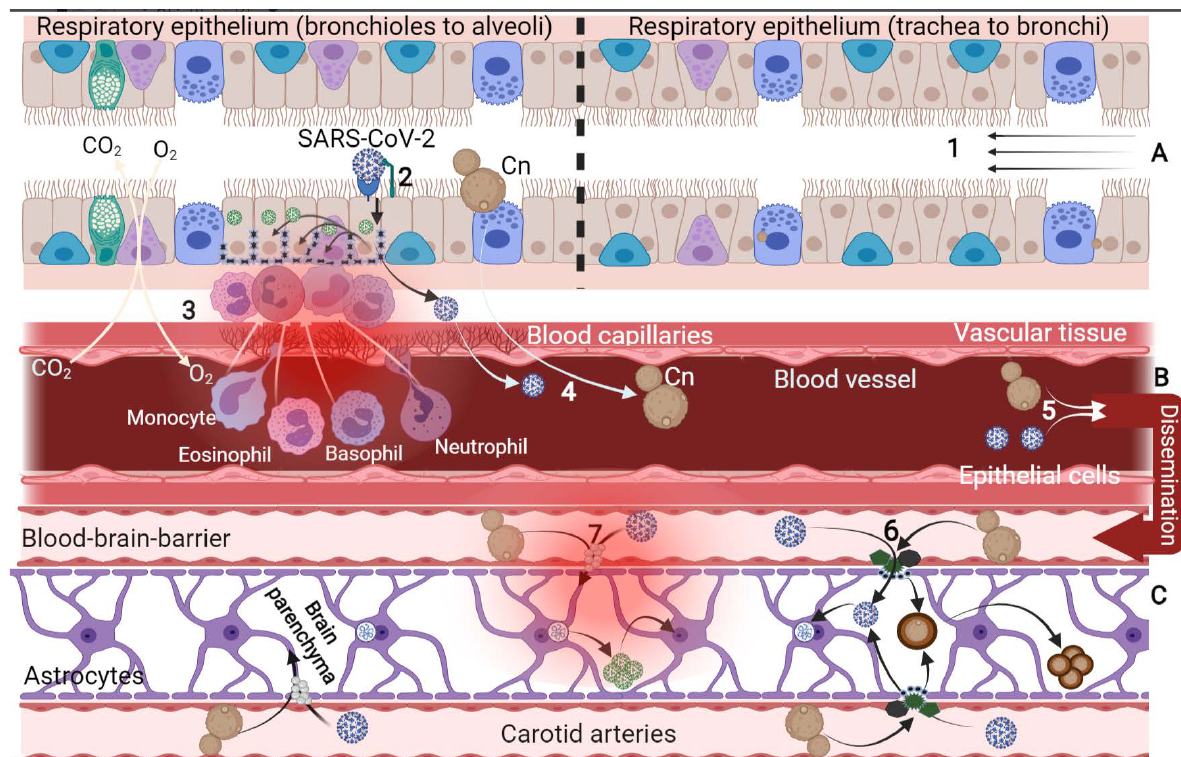
Figure 2. Pulmonary infection caused by C. neoformans and SARS-CoV-2 virus. Pulmonary cryptococcosis and severe acute respiratory syndrome caused by coronavirus share some common pathological features. These include targeting alveoli cells, impairing gas exchange mechanism, degrading epithelial surfactant, inducing a cell-mediated immune response, tissues’ invasion and dissemination, systemic inflammation, leucocyte infiltration, extrapulmonary circulation, and brain invasion via carotid arteries ( A – C ). ( 1 ) Air passageway from the upper to the lower respiratory system where infectious fungi ( C. neoformans ) and viral particles enter into the alveoli space. Infectious basidiospores are lodged in the alveoli and find their way across the epithelial tissue. Germinating yeasts are identified by the residential dendritic cells and macrophages that engulf and destroy the yeast pathogen. However, in immunocompromised patients, the pathogenic yeast survives the phagocytic effect and transport as “trojan horse macrophage” across the epithelial tissue into other body organs, including the brain, resulting in cerebral meningoencephalitis; ( 2 ) SARS-CoV-2 viral particles identify the hACE2 receptor followed by proteolytic cleavage to activate the virus for membrane fusion and endocytosis; ( 3 ) other epithelial cells are targeted by the replicating virus for destruction, which orchestrates pathological indexes including oxidative damage, mitochondrial degeneration, inflammation, and atrophy, which promote the secretion of pro-inflammatory cytokines and the infiltration of the leucocytes; ( 4 ) within this event, the viral particles and macrophage-surviving C. neoformans find their way into the blood (viraemia and fungaemia, respectively) via the retrograde blood capillaries; ( 5 ) pathogens end up disseminated into the brain region via carotid arteries and other systemic brain transport arterioles into the medulla and pons region; ( 6 ) at the BBB, C. neoformans could secrete vesicles of hydrolytic and proteolytic enzyme such as phospholipase, urease, metalloproteinase, and hyaluronic acid to enhance transcellular crossing into the brain parenchyma. Compromising the tight junction this way could also enhance intracranial invasion of the viral particles. Again, within the brain region, C. neoformans can synthesis melanin due to abundant DOPA substrates, form titan cells, and aggregate to colonise; ( 7 ) by way of hypothesis, extracellular protease of C. neoformans could possibly activate the virus S-protein to promote membrane fusion and endocytosis into the brain neuroglia and neurons via the retrograde nerve ending (dendrites). Viral genome translation, transcription, packaging, and replication in the brain cells lead to neuropathy and viral colonisation in the brain medulla and pons. This leads to neuronal dysfunctions, pathologically characterised by encephalitis, inflammation, cytokine flooding, demyelination, impaired breathing, cardiac rate, muscle contraction, and blood